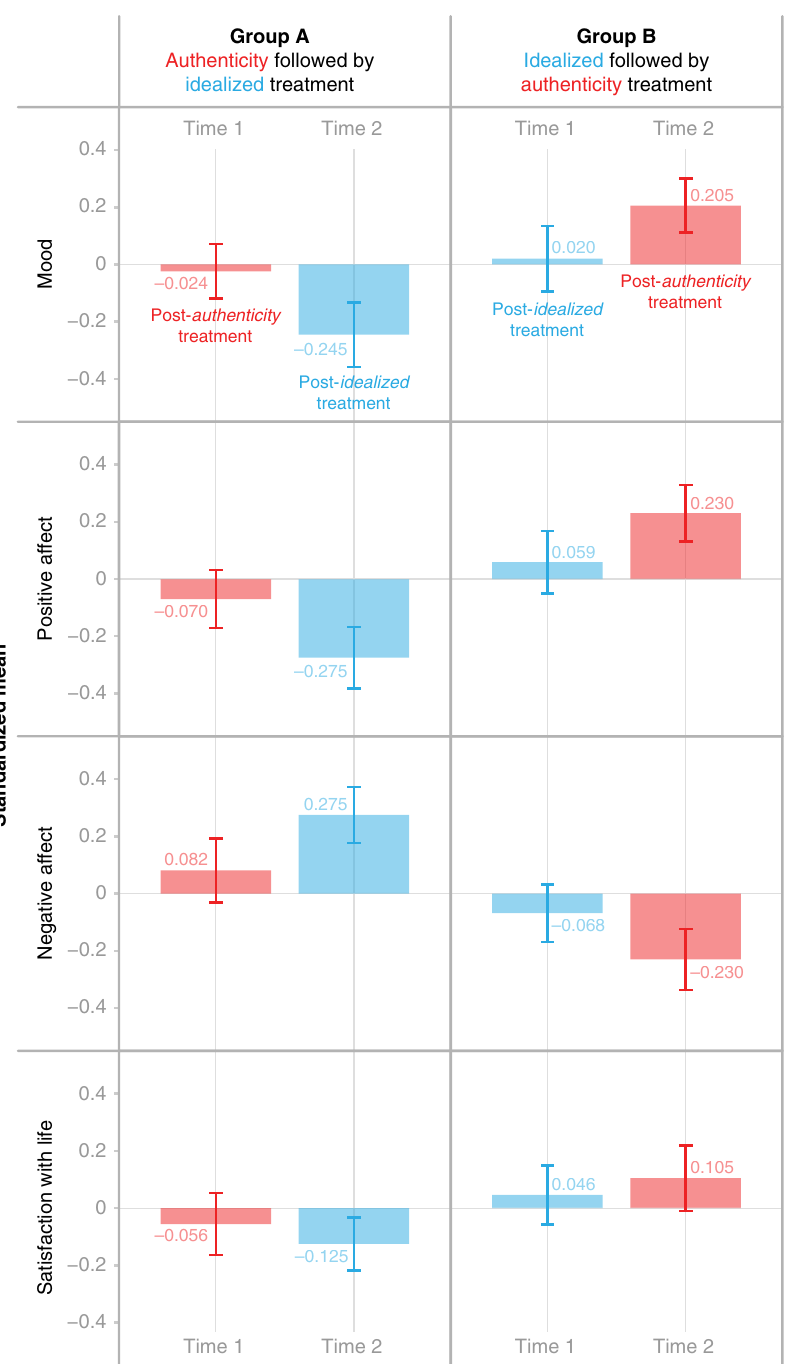
Fig. 3 Experimental outcomes by authenticity and idealization treatment. The bar chars illustrate the standardized mean of well-being indicators (mood, positive affect, negative affect, and Life Satisfaction) across two study time points by condition. The red bars indicate scores for the weeks in which participants were asked to post authentically, and the blue bars scores for the weeks in which they were asked to post in a self-idealized way. Error bars represent standard errors. The left-side panel presents Group A who received the authenticity treatment followed by the idealized treatment. The right-side panel presents Group B who received the idealized treatment followed by the authenticity treatment. This experiment was conducted once with independent samples in each